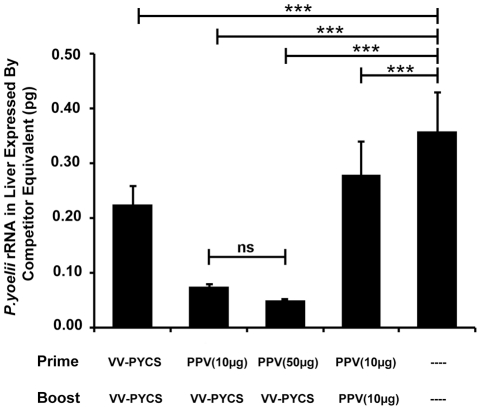
Protective capacity of PPV-PYCS prime followed by booster with replication competent VACV vector expressing CS.Groups of BALB/c mice (5 per group) were immunized with different amounts of PPV-PYCS [PPV(10 µg) and PPV(50 µg)] or non-vaccinated and two weeks later animals were boosted with the replication competent VACV vector from the WR strain (referred as VV-PYCS) or with PPV-PYCS. Thirteen days later, animals were challenged with sporozoites and the amount of parasite rRNA in the liver of each animal was estimated 42 h after the challenge, as described under Materials and Methods. Results are expressed as the mean with standard deviation. Statistical values were determined by one-way ANOVA; P values, *P<0.05, **P<0.01, ***P<0.001. Lane (–), non-vaccinated.